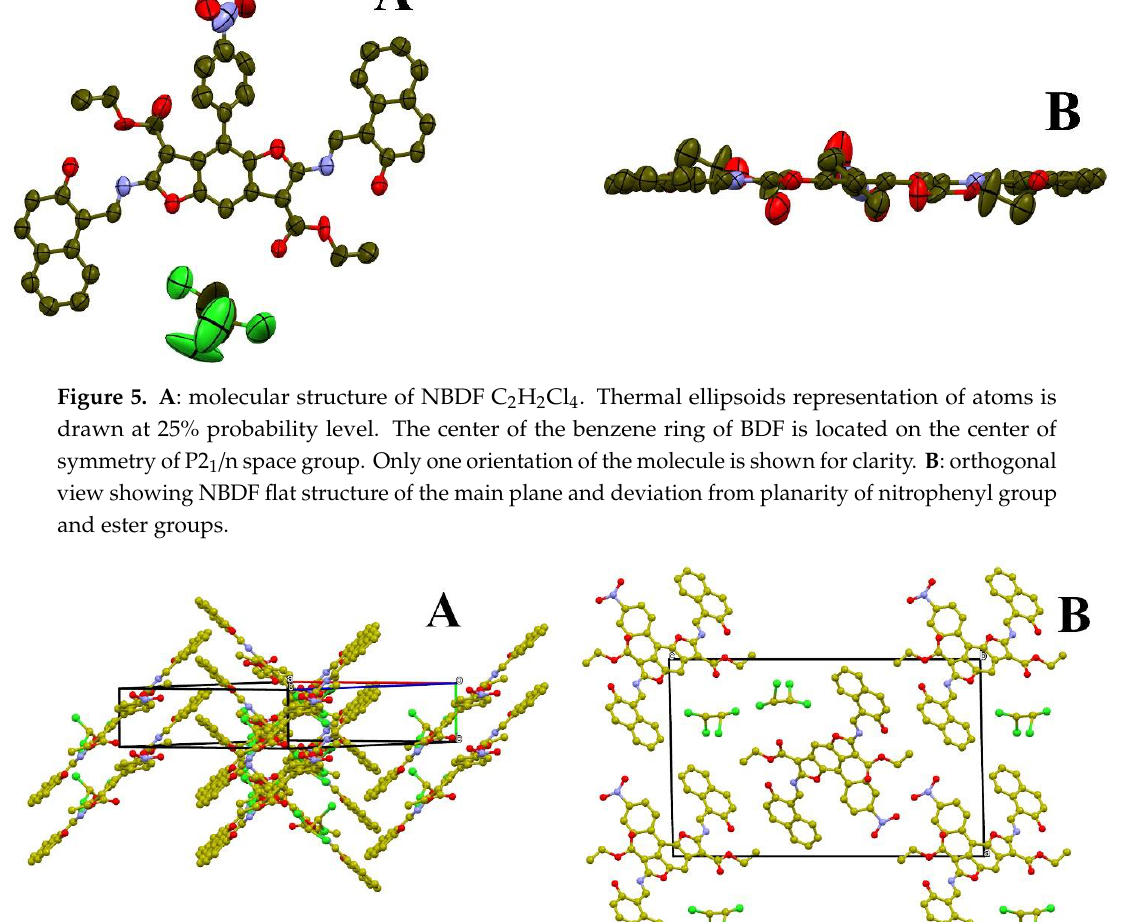
Figure 6. A : crystal packing forming a columnar arrangement of π -stacked NBDF molecules. B : crystal